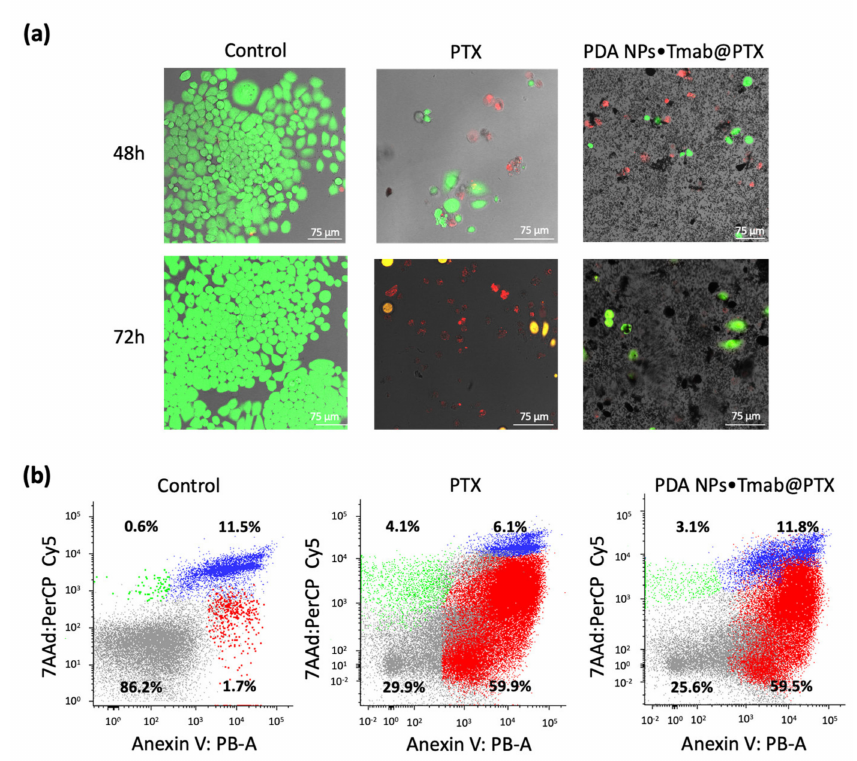
Figure 4. ( a ) CLSM images of BT474 cells 48 and 72 h after treatment with PTX (99.5 nM) and PDA NPs • Tmab@PTX (0.035 mg/mL). Cell viability and death were assessed by using calcein AM (green) and propidium iodide (red), respectively; ( b ) flow cytometry analysis showing the percentage of apoptotic and necrotic BT474 cells 48 h after treatment with PTX (99.5 nM) and PDA NPs • Tmab@PTX (0.035 mg/mL). The vertical axis indicates the cells labeled with 7AAD (PerCP) and the horizontal axis indicates those stained by Annexin V (FITC) (early apoptosis: right lower, late apoptosis/necrosis: right